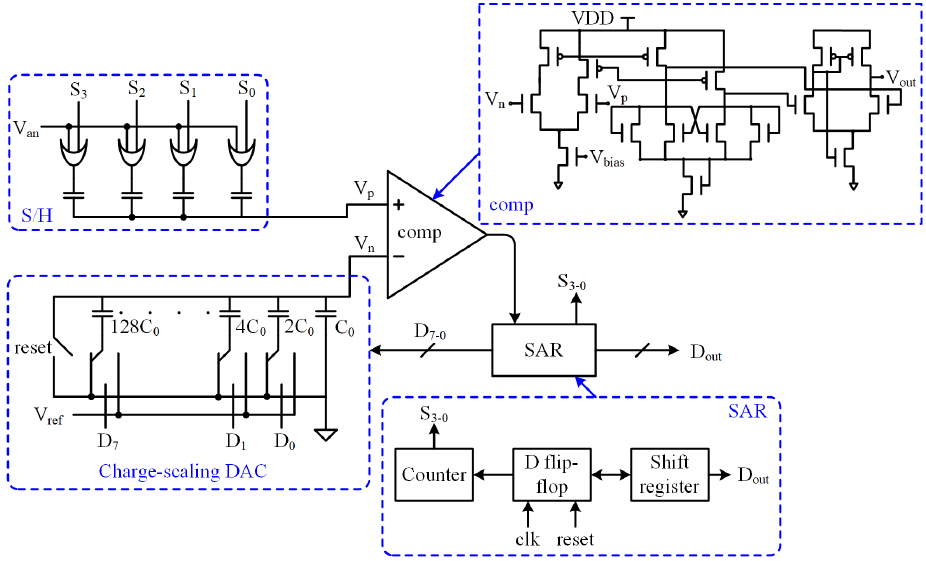
Figure 3. Schematic of the 8-bit successive approximation register analog-to-digital converter